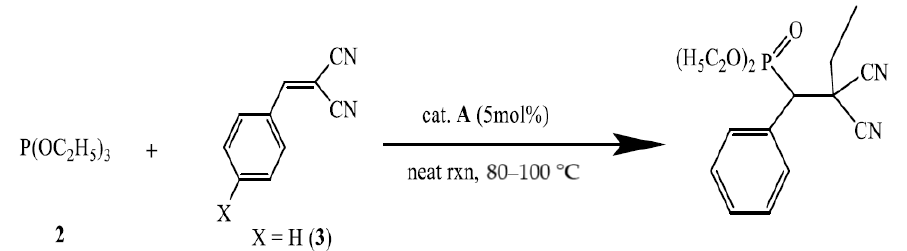
Reaction conditions: T = 80–100 ◦ C, cat. A (5 mol%), 2 (0.25 mL, 1.5 mmol), 3 (115 mg, 0.75 mmol), solvent free reaction. a Measured by GC/MS; b isolated yield in parenthesis.